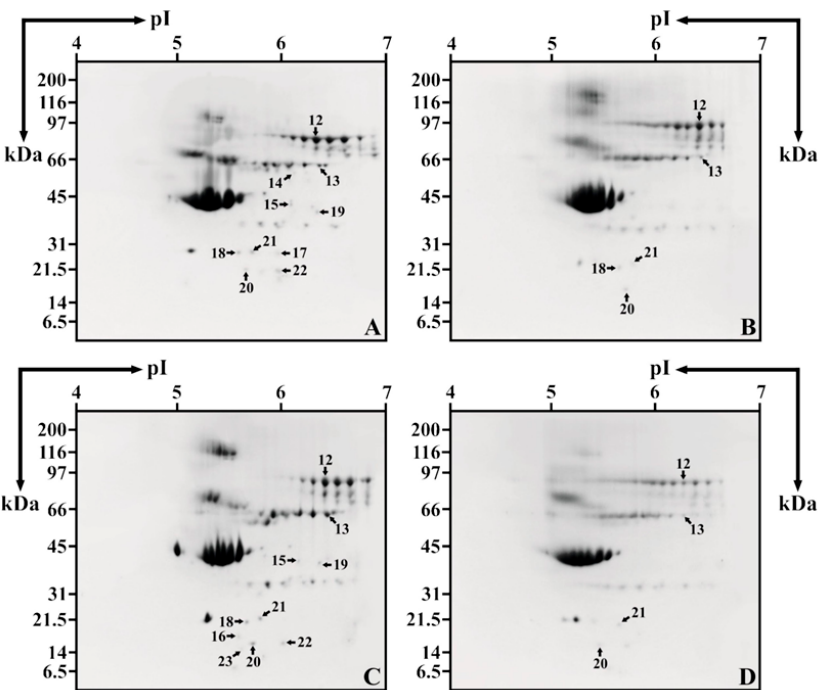
Figure 6. 2D-PAGE separations of the legumin fraction (( A )—cv. Nadwi ś la ń ski seeds stored at − 14 °C; ( B )—cv. Nadwi ś la ń ski seeds after +20 °C storage; ( C )—cv. Dino seeds stored at − 14 °C; ( D )—cv. Dino seeds stored at +20 °C). Agriculture 2020 , 10 , x FOR PEER REVIEW